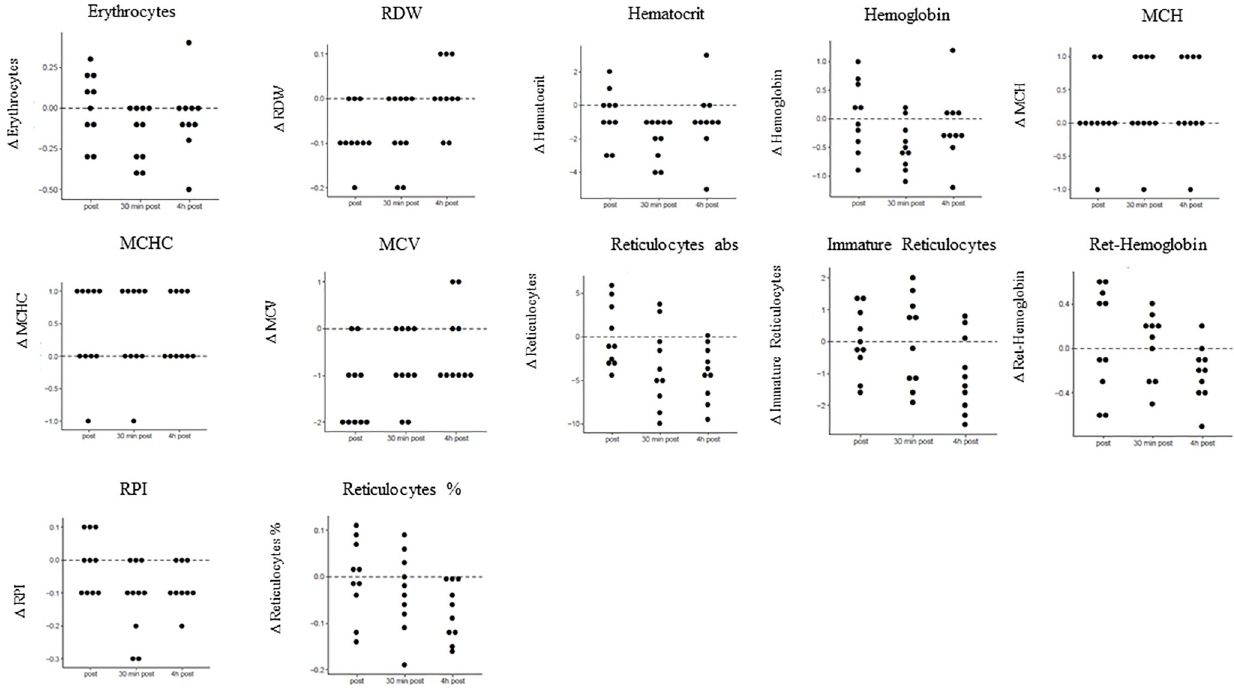
Fig 1. Concentration changes of red blood cell parameters compared to baseline. Displayed are concentration changes at the three different time points post apnea, 30 min and 4 h post apnea compared to baseline values for red blood cell parameters. https://doi.org/10.1371/journal.pone.0237673.g001 were found for leucocytes, lymphocytes, immature granulocytes, monocytes, basophile gran- ulocytes, neutrophil granulocytes and eosinophil granulocytes. P -values as well as mean values ± SD for baseline concentration, before apnea, and immediately and 0.5 h and 4 h after apnea are presented in Table 3. Differences between the three time intervals versus Table 3. Mean values, standard deviations and p -values at four different time points (baseline concentrations, immediately post apnea, 0.5 h and 4 h after apnea) of white blood cell